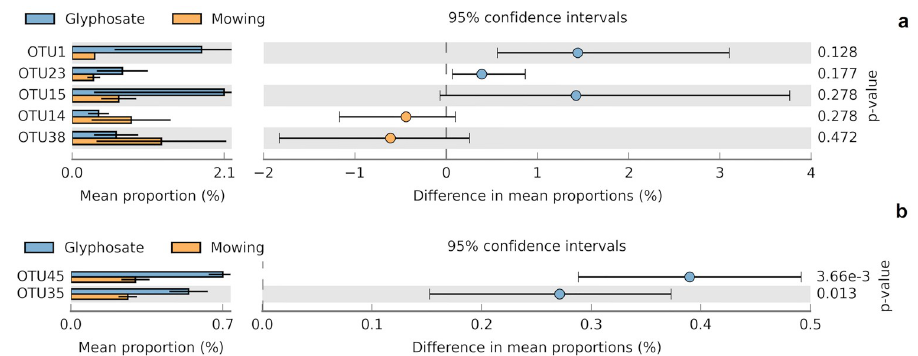
Fig 4. Comparison of mean relative abundance between suppression methods at OTU level (with effect size filters). Panel a: 4 days, Panel b: 26 days. White’s non-parametric t-test was used for statistical analysis ( α = 0.05). Only those categories with a minimum relative abundance of 0.2% in each sample are shown. Confidence intervals and P - values are indicated in each case. Effect size filter: RP > 2.